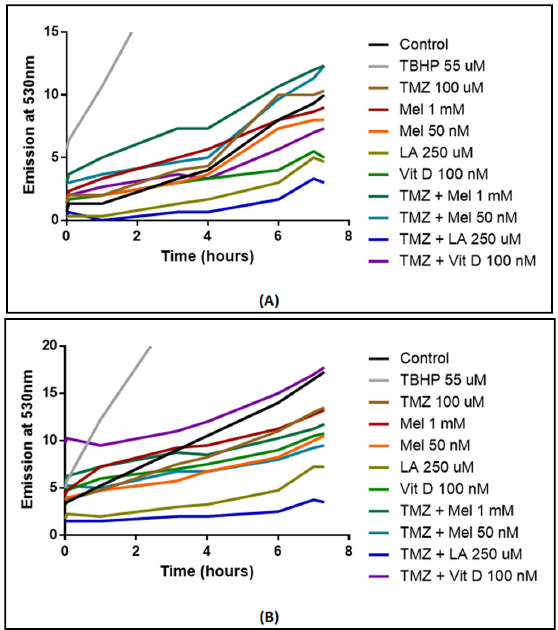
Figure 5. Reactive Oxygen Species (ROS) measured via 2 ′ ,7 ′‐ dichlorofluorescin diacetate (DCFDA) fluorophore in U87 ‐ MG ( A ) and MU1454 ( B ) after treatment with antioxidants (Vitamin D [Vit D], Lipoic acid [LA], or Melatonin [Mel]) and/or temozolomide (TMZ) at 100 uM. Dosages of antioxidants are specified on the graph. Positive control was 55 µ M of tert-butylhydroperoxide